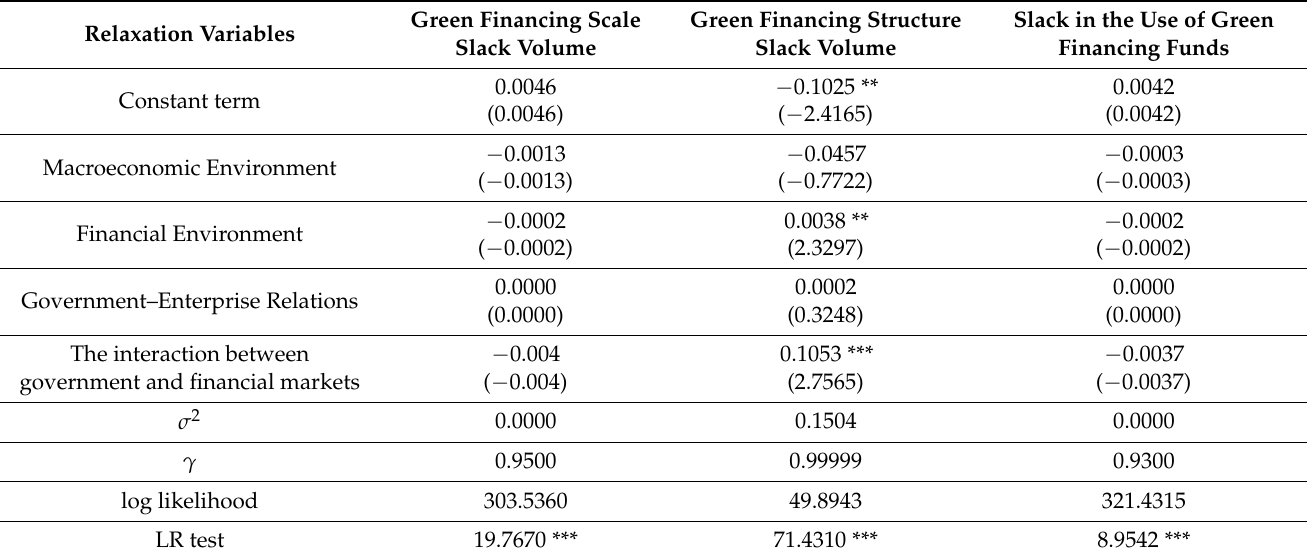
Table 10. SFA regression results for listed companies in the architectural design and services